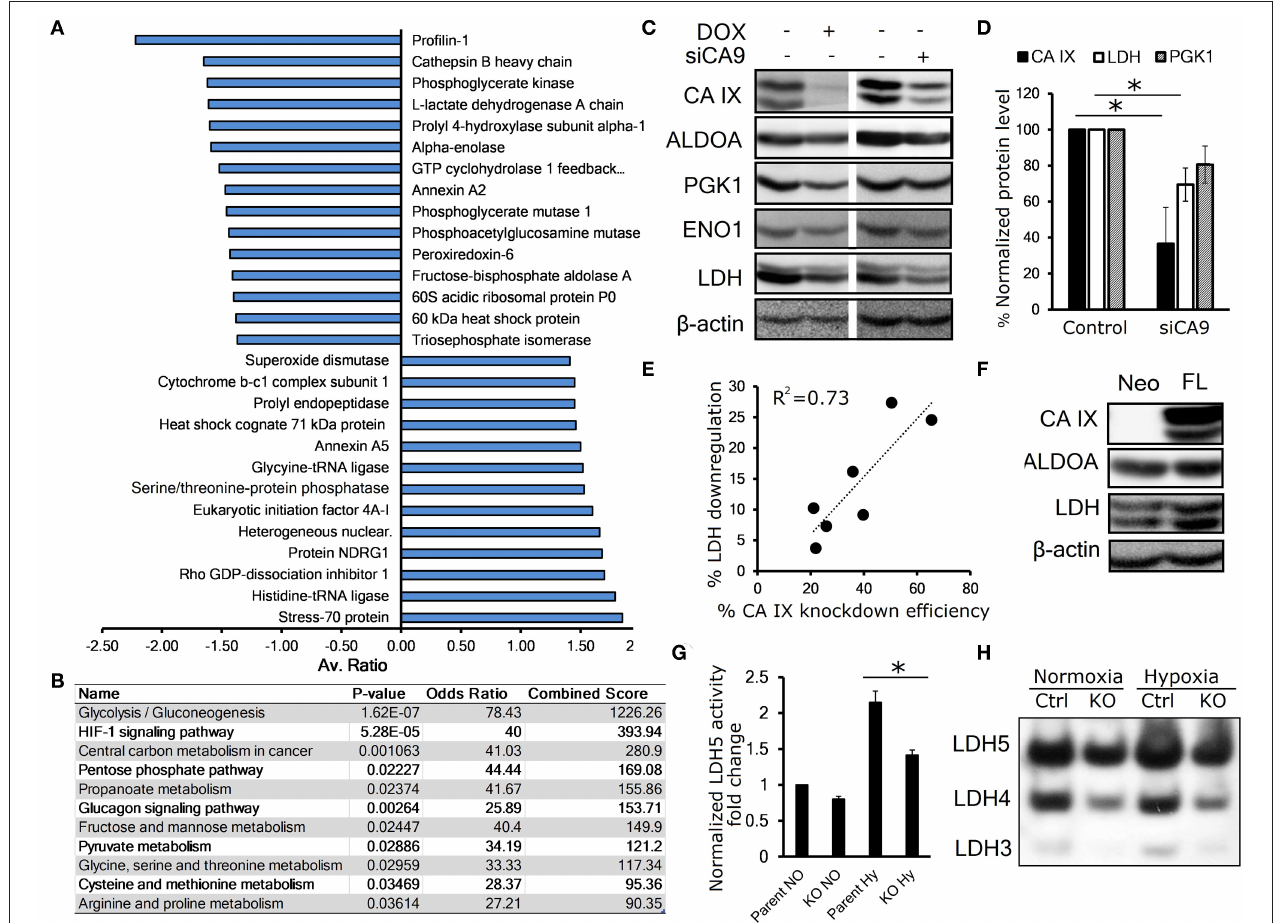
FIGURE 1 | CA IX knockdown decreases the abundance of key glycolytic enzymes. (A) Average fold change of proteins affected by doxycycline (DOX)-induced CA IX knockdown in hypoxic HeLa DOX cells incubated in 0.5% serum for 48h, determined by 2D-DIGE analysis ( n = 3). (B) KEGG pathway analysis of under-represented proteins in response to knockdown of CA IX. P -value is computed from the Fisher exact test for probability of the set of genes belonging to a specific pathway. Odds ratio and Combined score are additional biostatistical means representing the probability that the selected gene set is component of the respective pathway. All computations were provided by the Enrichr data analysis platform ( 15, 16). (C) Representative immunoblots showing the effect of CA IX knockdown in HeLa DOX (left) and HeLa KD (right) cells incubated in 2% O 2 for 48 h ( n = 3). (D) Impact of CA IX knockdown (siCA9) on LDH and PGK1 levels normalized to β -actin in HeLa KD cells incubated in 2% O 2 for 48h ( n = 5). (E) Dose-response relationship between CA IX knockdown and reduction of LDH levels in hypoxic HeLa KD cells. (F) Representative immunoblot showing increased ALDOA and LDH in CA IX-transfected C-33A cells (C33 A-FL) that lack endogenous CA IX expression incubated in 2% O 2 for 48h ( n = 3). (G) LDH5 activity of HT-1080 CA IX knockout (HT-1080 KO) in normoxia and 48h 1% hypoxia ( n = 3). (H) Representative LDH activity assay showing separated LDH5-LDH3 isoforms stained for LDH activity ( n = 3). Error bars are ± SD. P -values were calculated against control by t-test. * P <